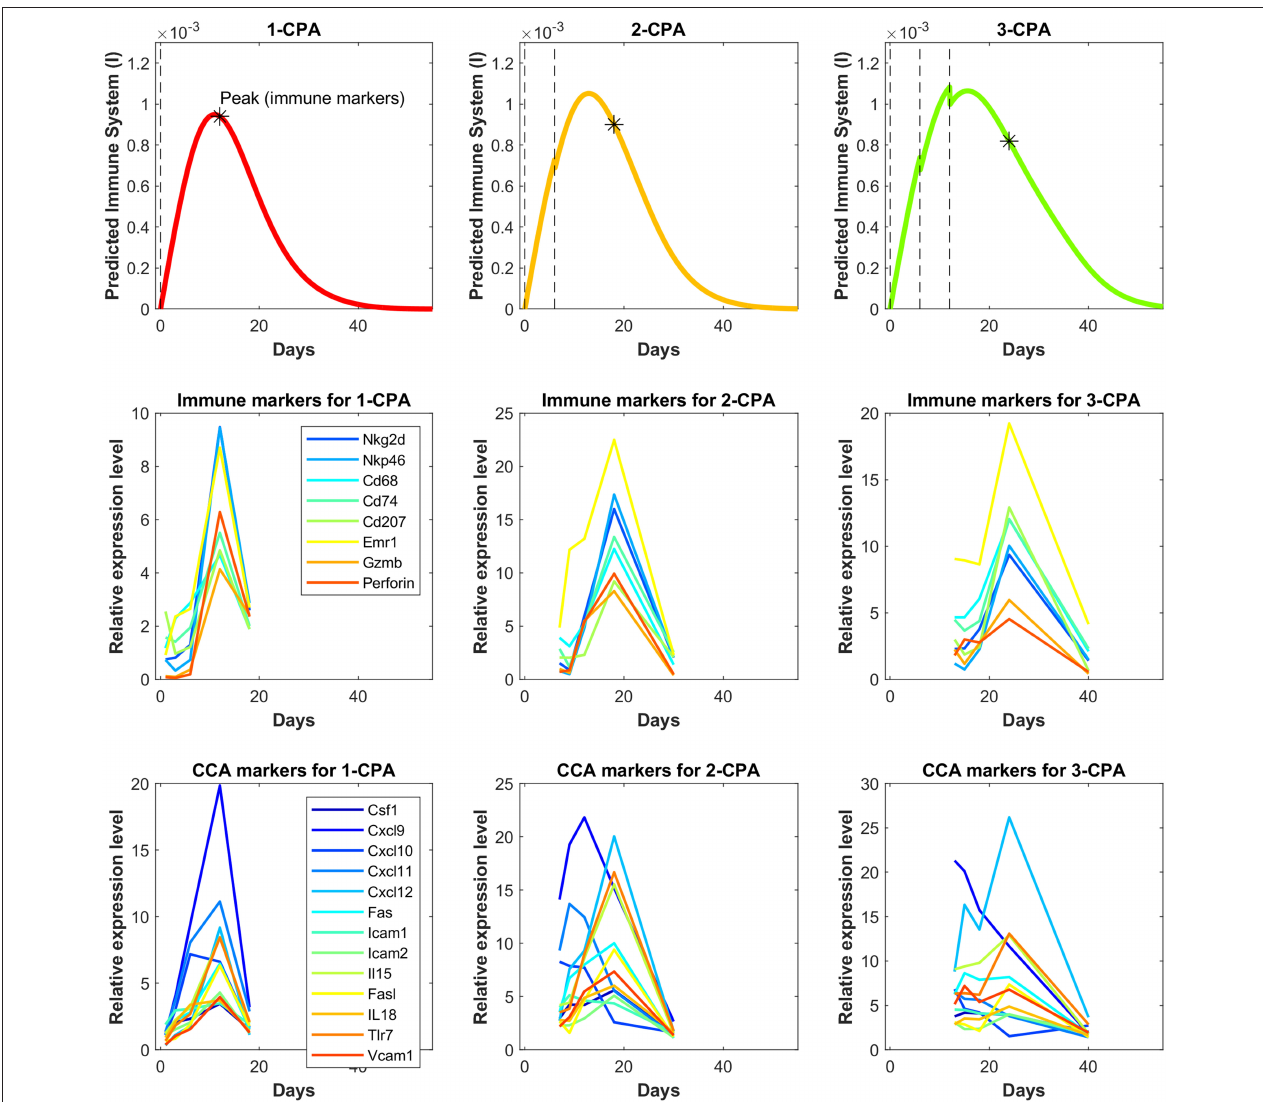
FIGURE 6 | Independent model validation through comparison of model predictions to available immune cell data. The top row shows the predicted immune system recruitment by the fitted model for the 1-CPA, 2-CPA, and 3-CPA treatment conditions. The vertical black dashed lines indicate times of drug injections at 140 mg/kg. The initial volume for the simulated tumors yielding these curves was assumed to be 1,000 mm 3 at the time of the first injection. The middle row shows the experimental data of the gene expressions for various immune markers linked to the innate immune cells (macrophages, dendritic, and NK cells). Similarly, the bottom row shows gene expression data for various chemokines, cytokines, and adhesion molecules (abbreviated CCA on the plots). The data is ordered such that each column represents the same treatment